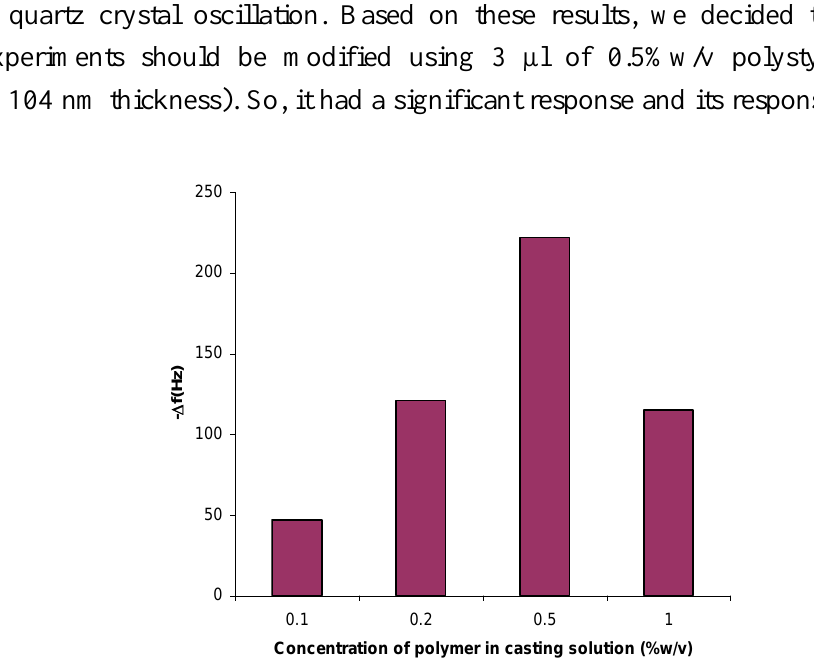
Figure 2. The effect of polymer concentration of casting solution (polymer thickness) on frequency changes of polystyrene-modified quartz crystal electrode exposed to 15 mg l − 1 toluene.